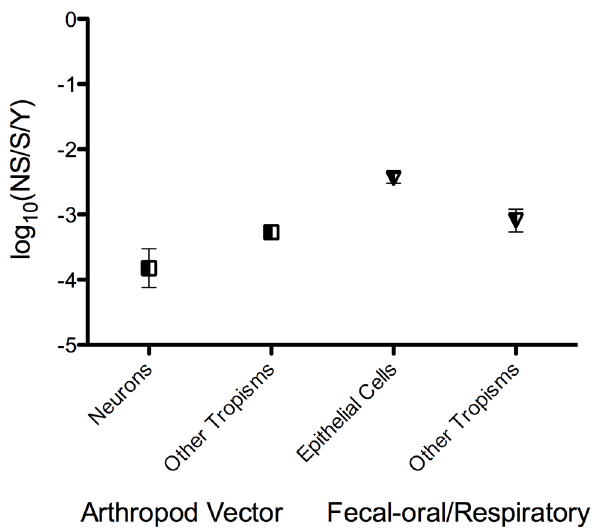
Figure 5. Nucleotide substitution rate variation among arbo- viruses and fecal-oral/respiratory transmitted viruses with different cell tropisms. The means of the log-scale mean nucleotide substitution rates of neurotopic (n=13) and non-neurotropic (n=38) arboviruses are shown as squares on the left, and the means of the log- scale mean nucleotide substitution rates of viruses that are transmitted through the fecal-oral/respiratory routes and primarily target epithelial cells (n=73) and those that are transmitted through the fecal-oral/ respiratory routes and primarily target other cells (n=15) are shown as the triangles on the right. The mean of each group is shown with 95% confidence intervals (CIs), except for non-neurotropic arboviruses, where the CIs are eclipsed by the